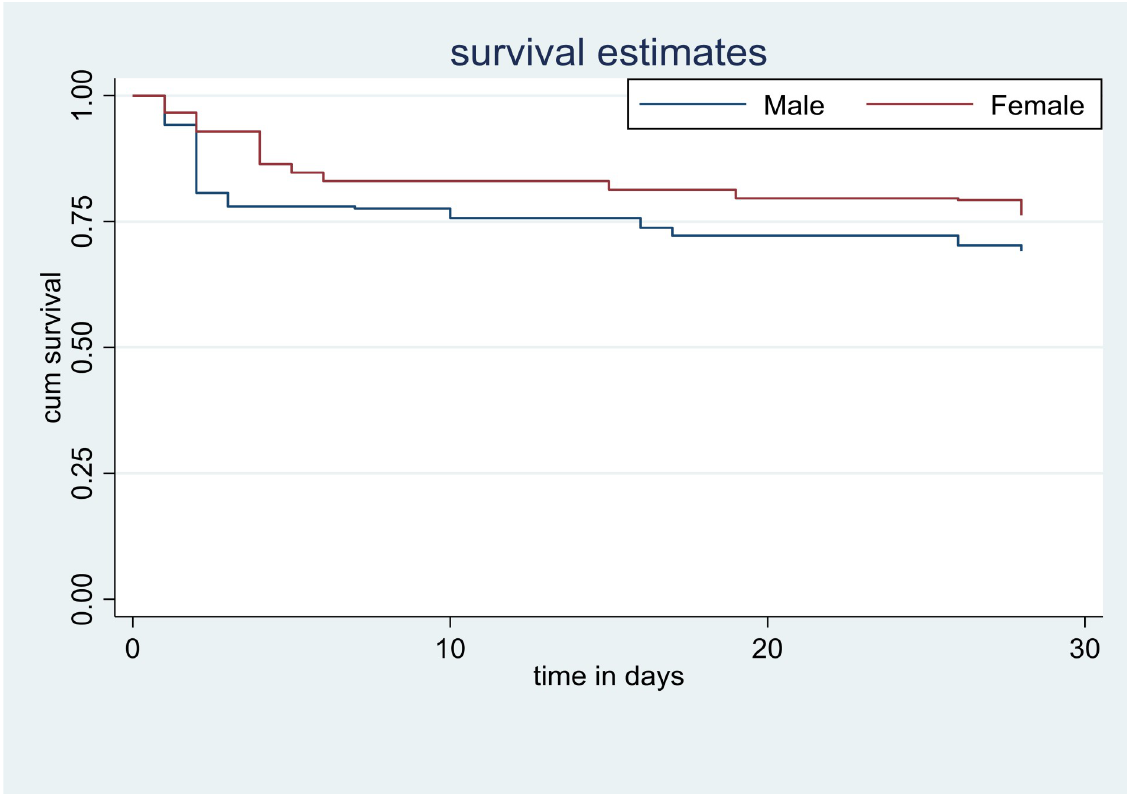
Fig 1. Survival probability curves derived from Log rank Kaplan Meier of fatality after 28 day follow up and sex.